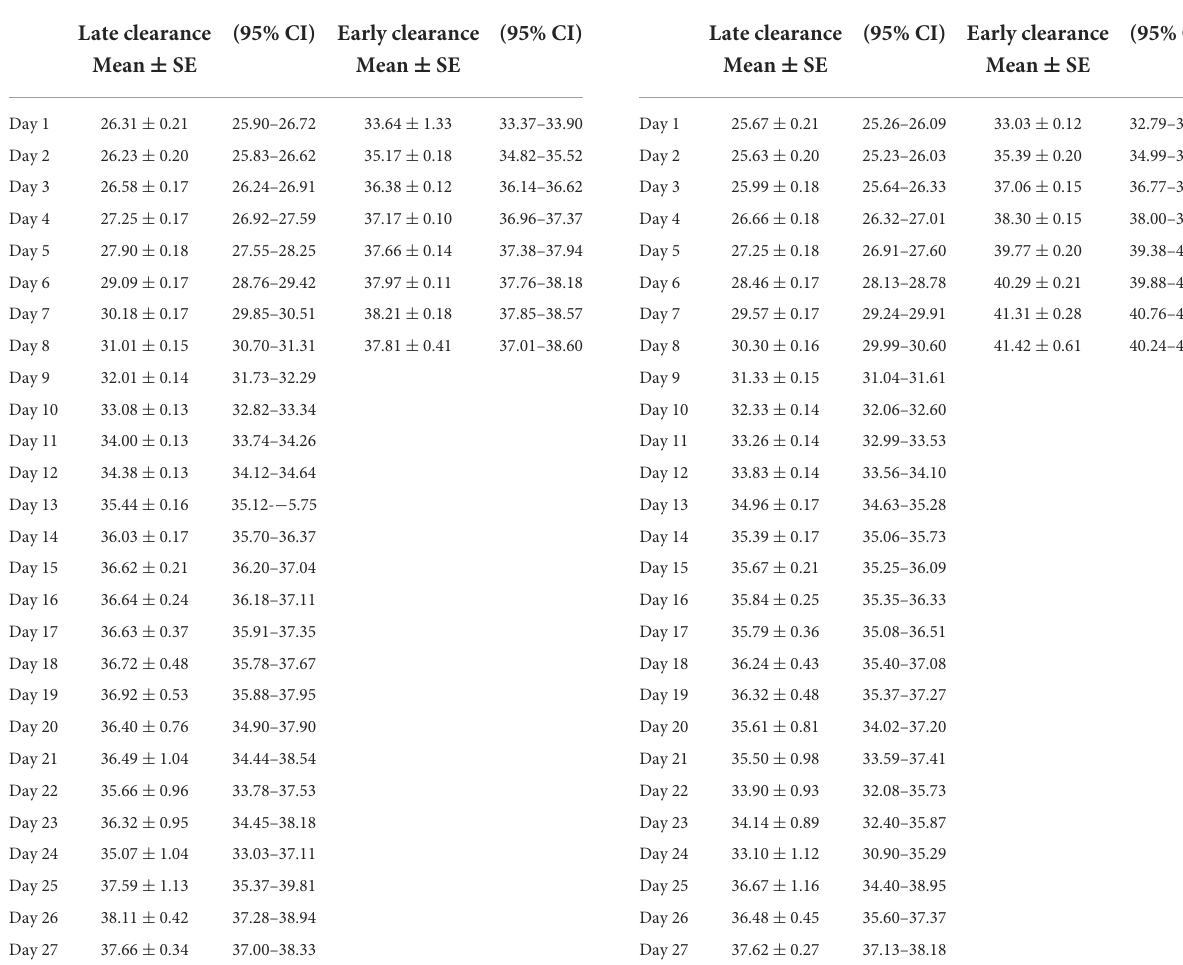
TABLE 4 Ct values of ORF 1ab gene over time after admission (Mean ± SE, 95% CI).